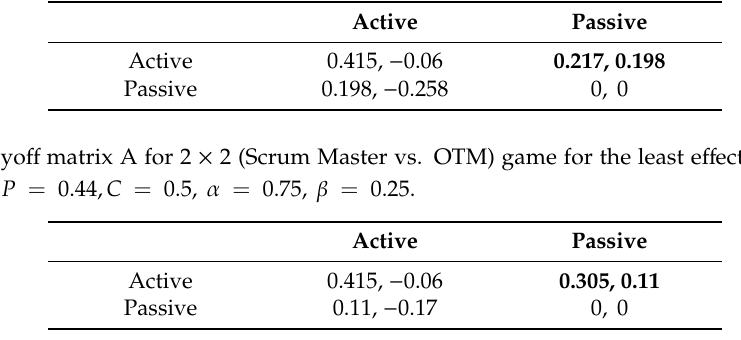
Table 8. Payo ff matrix A for 2 × 2 (Scrum Master vs. OTM) game for the least e ff ective team